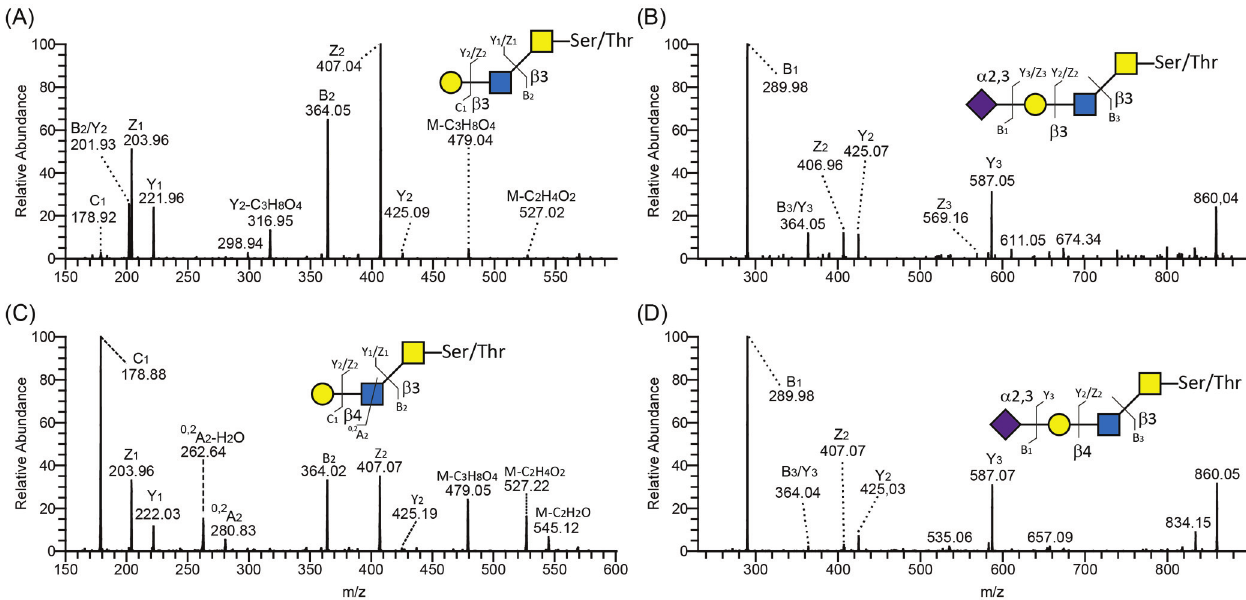
Figure 5. LC-MS/MS spectra of core 3 O -glycans containing type 1 and 2 outer core chains. MS/MS spectra of type 1 ( A , B ) and type 2 ( C , D ) chain-containing O -glycans on core 3 released from PSGL-1/mIgG2b produced in CP-C3-T1. Proposed structures are depicted